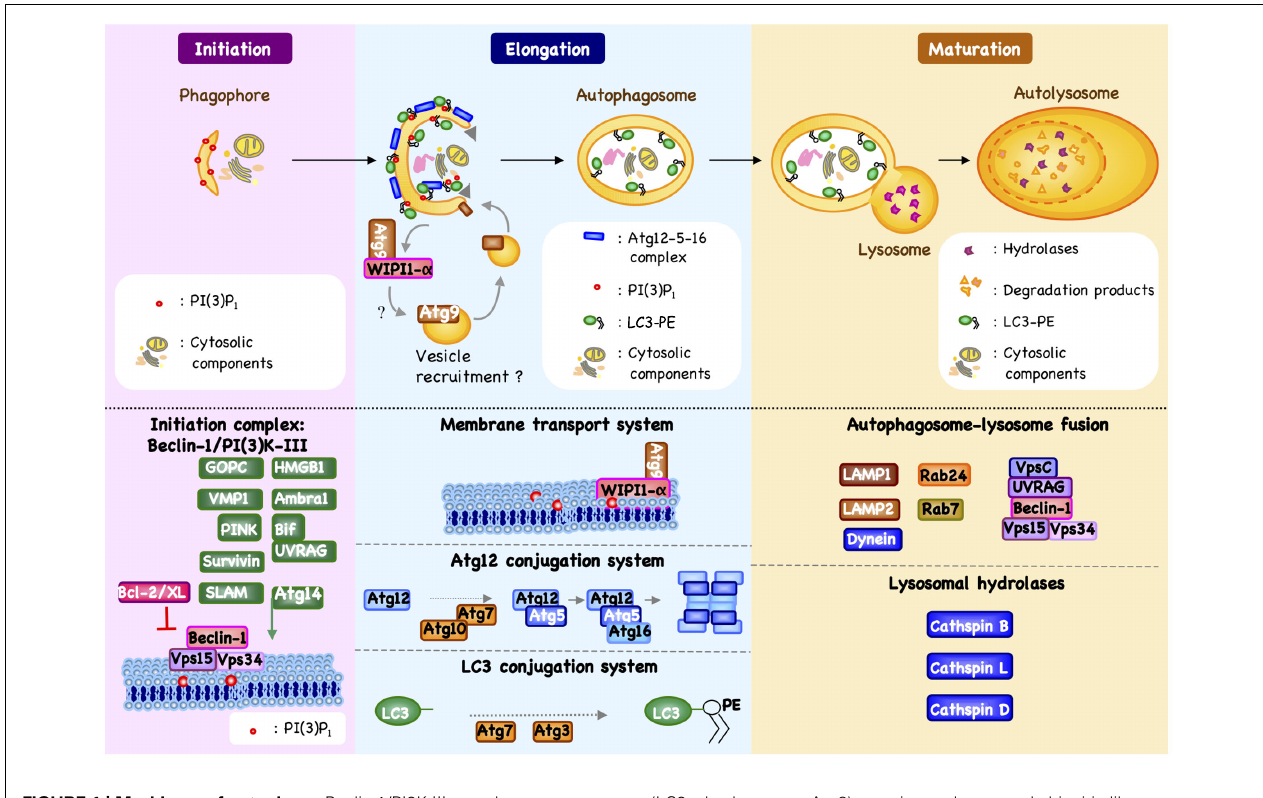
FIGURE 1 | Machinery of autophagy. Beclin-1/PI3K-III complex activation, which is regulated by different mechanisms, results in the formation of phosphatidylinositol 3-phosphate [PI(3)P1] and the induction of an autophagic vesicle, which is characterized by a double-membrane, and termed an autophagosome (Crotzer and Blum, 2010; Mehrpour et al., 2010; Kang et al., 2011).Two ubiquitin-like systems have been shown essential for autophagosome formation. In the first, autophagy-related gene-12 (Atg12) is conjugated to Atg5, together forming a complex with Atg16L1, which decorate the outer membrane of the isolation membrane. Microtubule-associated protein 1 light chain-3